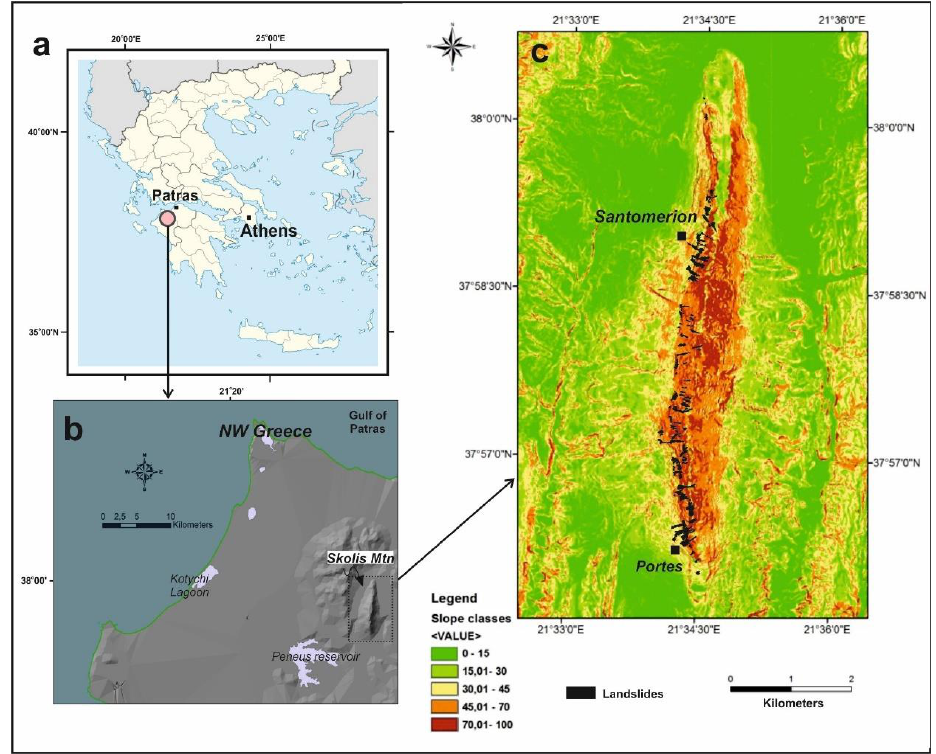
Figure 1. ( a ) Location map and ( b ) shaded relief map of the study area; ( c ) Slope map of Skolis Mountain.